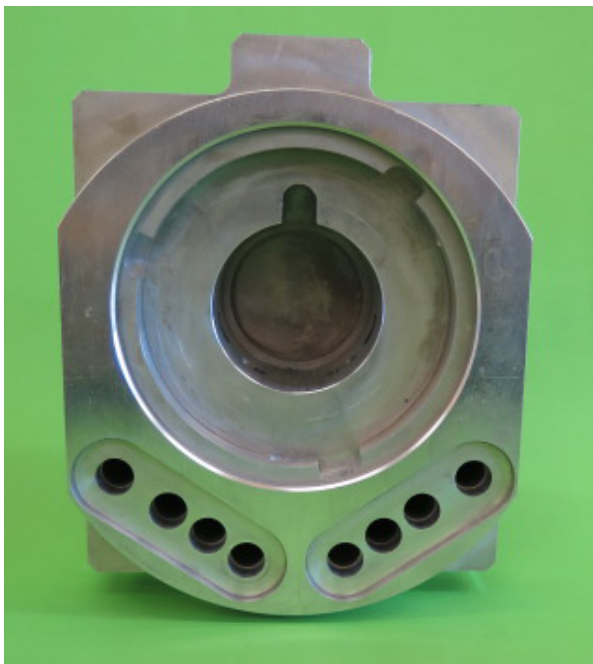
Figure 7. An open tandem target holder with the bayonet-mount plug